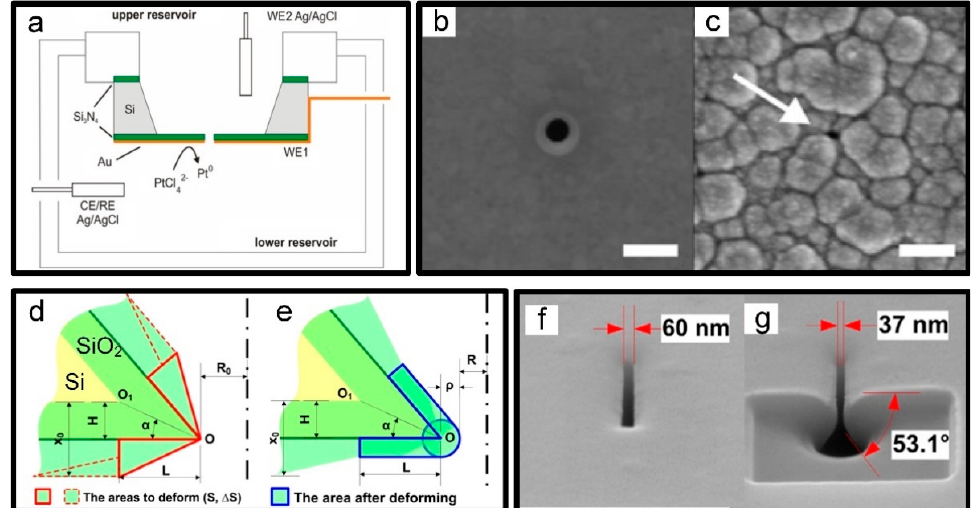
Figure 6. ( a ) Schematic diagram of electrochemical deposition. SEM images before ( b ) and after ( c ) electrodeposition (scale bar: 200 nm) [46]. ( d , e ) Schematic diagrams of the nanopore shrinkage induced by thermal oxidation: ( d ) growth of a SiO 2 layer; ( e ) deformation of the SiO 2 layer. ( f , g ) The inner structure of a nanopore before ( f ) and after ( g ) shrinkage [102] .